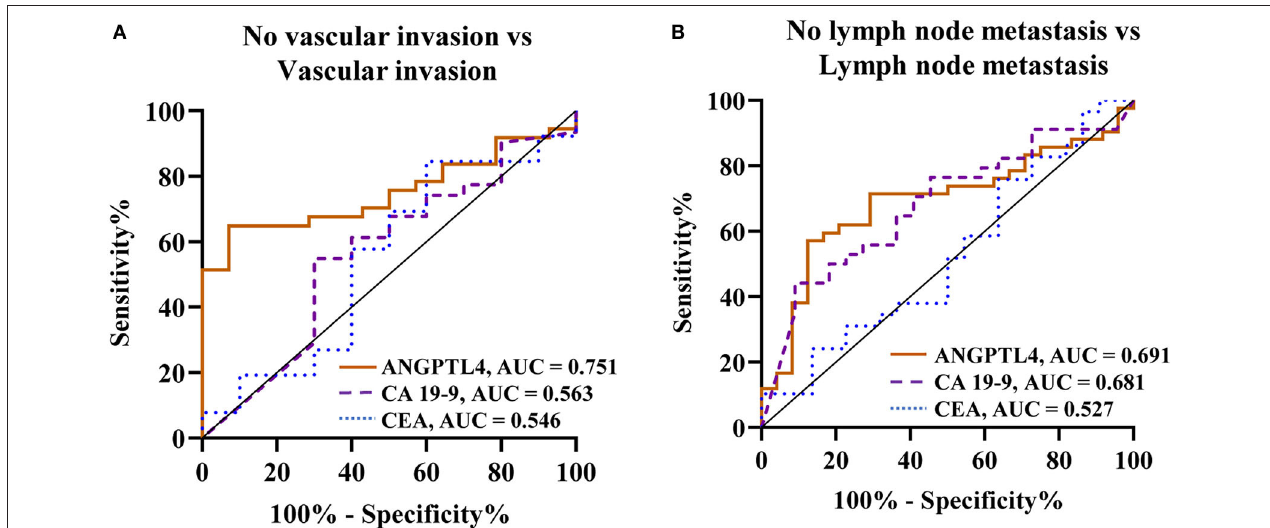
FIGURE 4 | ROC curve analysis of biomarkers (ANGPTL4, CA 19-9, and CEA) for prediction of CCA in comparison group of (A) No vascular invasion vs. Vascular invasion, (B) No lymph node metastasis vs. Lymph node metastasis. Bold values * Statistical significance ( p < 0.05).